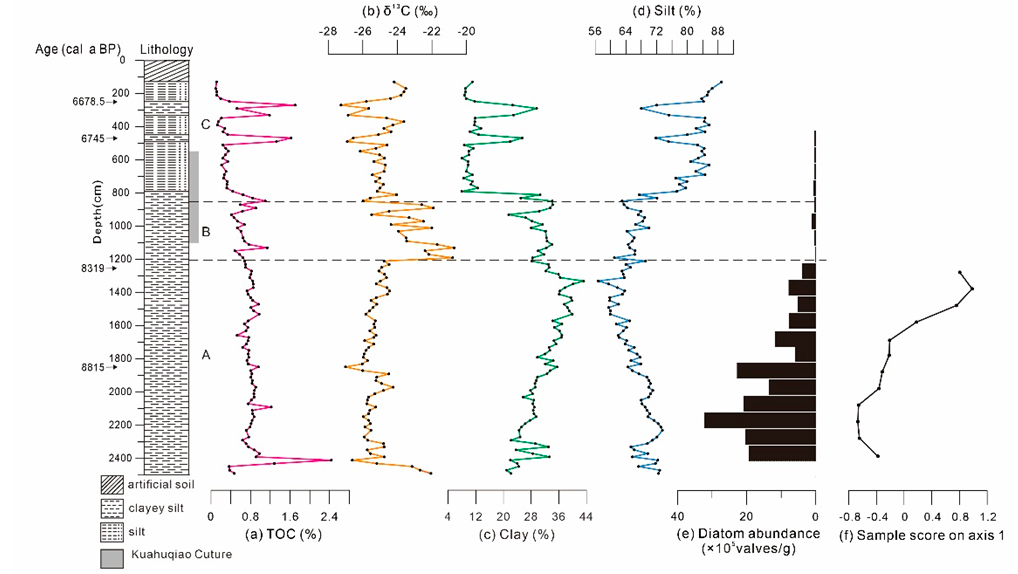
Figure 5. Results of ( a ) TOC content, ( b ) δ 13 C, ( c ) clay content, ( d ) silt content [35], ( e ) diatom abundance, and ( f ) Sample score on axis 1 of core XH-2.